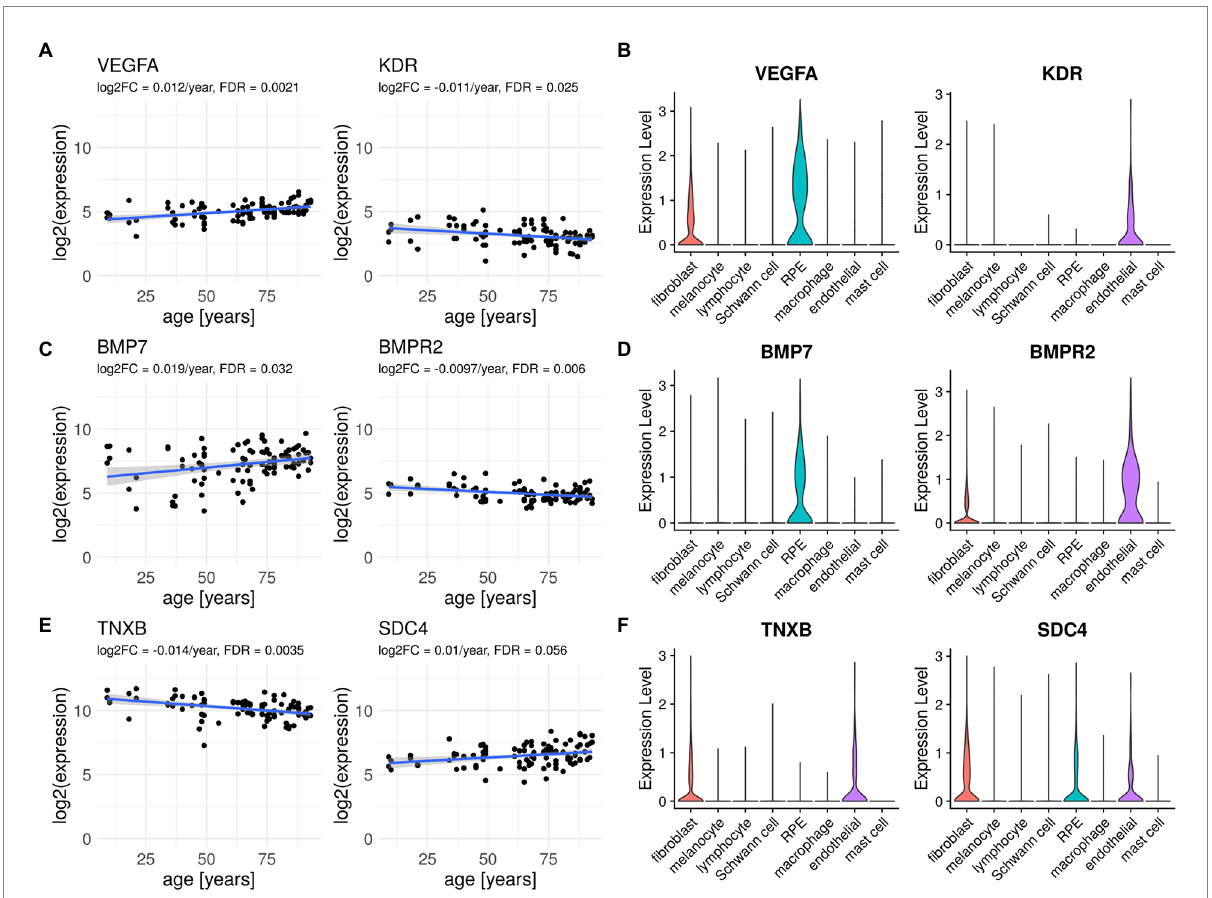
FIGURE 4 Ligand and receptor genes differentially expressed with age in the RPE/choroid with their typical cell type-specific expression. (A,C,E) Scatter plots of selected ligands and receptors showing expression changes with age in human RPE/choroid microarray samples from Newman et al. (2012). Displayed Log2FC and FDR are those computed with Limma according to the linear model described in Methods. (B,D,F) Violin plots showing expression levels of corresponding genes in RPE/choroid cell types from scRNA-seq samples of Voigt et al.